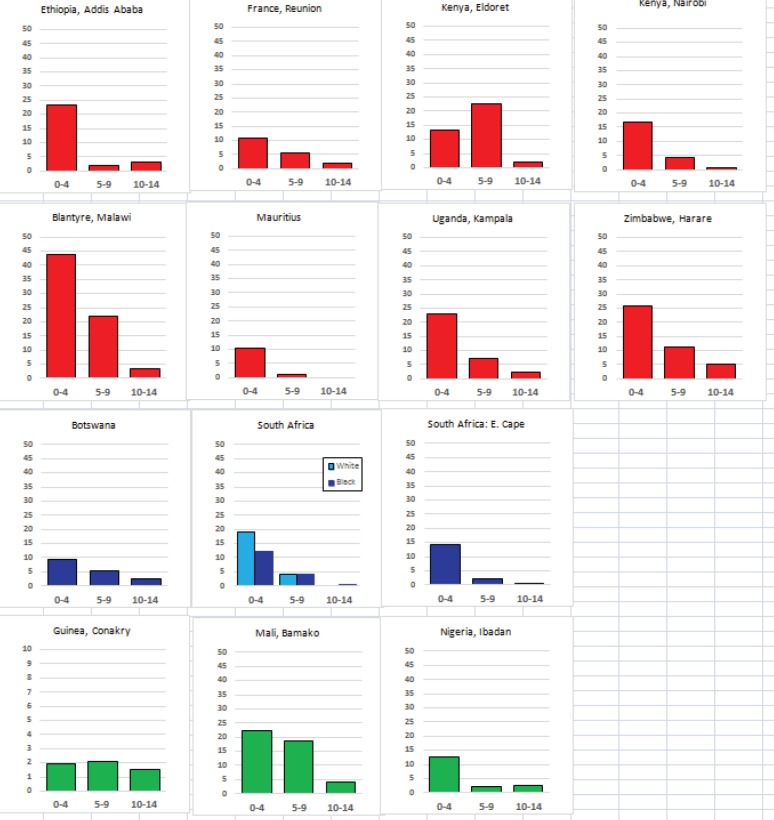
Age-specific histograms—nephroblastoma.